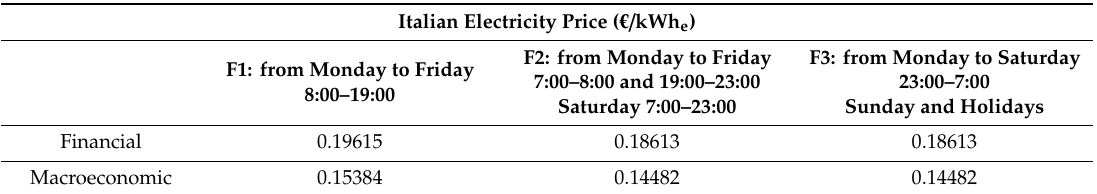
Table 7. Average electricity price determined for the quarter January–March 2019 concerning the Italian market, as a function of the three intervals defined by the time for intended use.